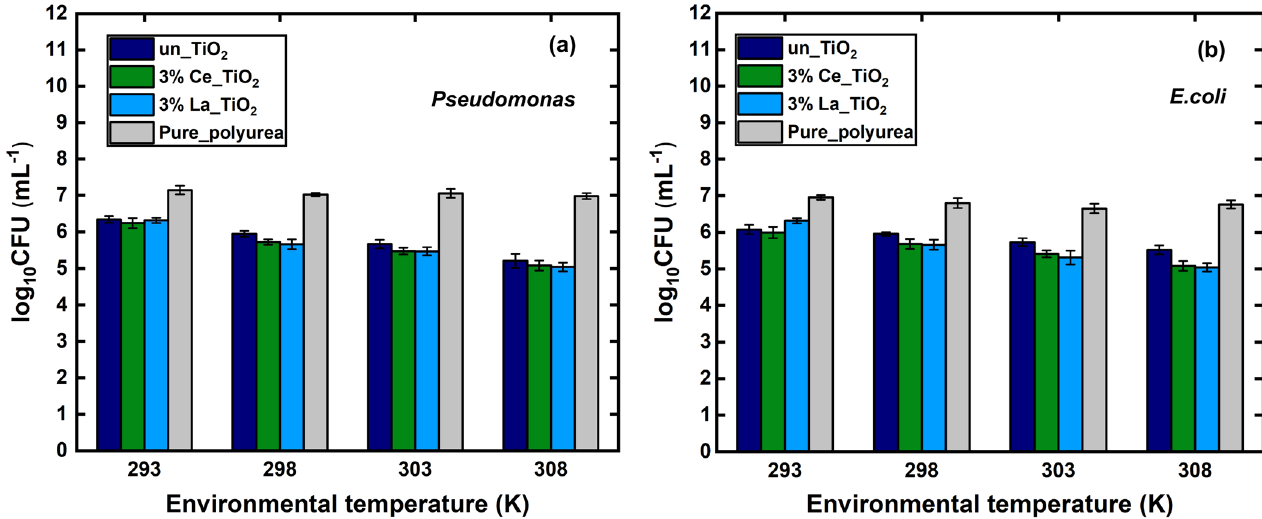
Fig. 8 Increment of antibacterial effect with different temperature within different bio fi lm reactors. a E. coli CDC-reactor and b Pseudomonas CDC-reactor & Increment of antibacterial effect with higher environmental temperatures within E. coli CDC-reactor and Pseudomonas